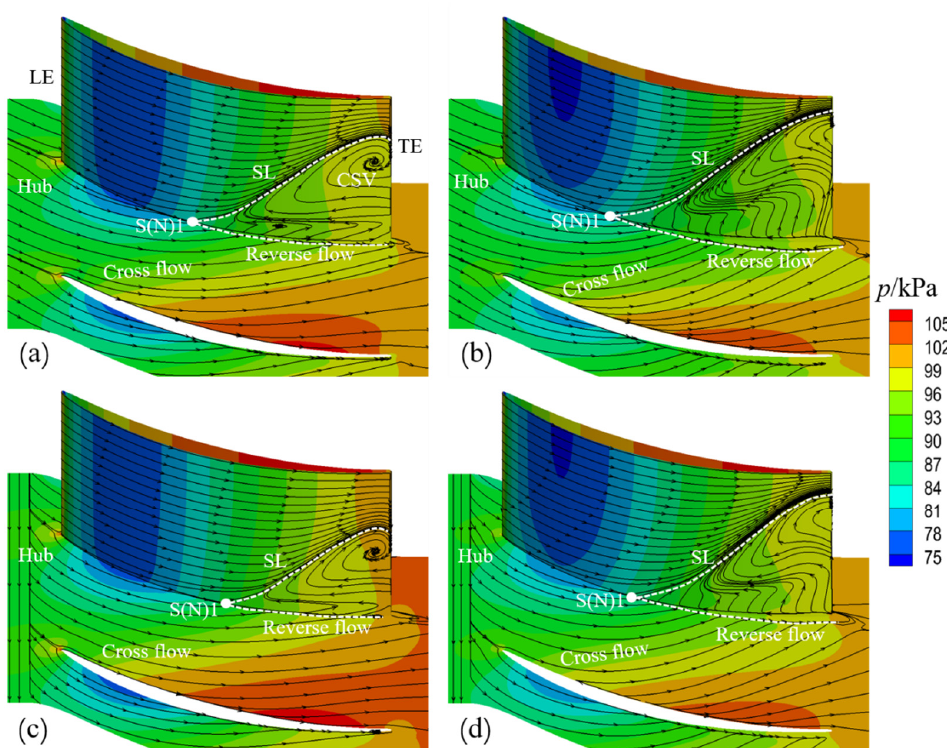
Figure 9. The limiting streamlines and static pressure contours of the original cascade endwall and suction surface: ( a ) 0 mm collateral; ( b ) 5 mm collateral; ( c ) 0 mm skewed; ( d ) 5 mm skewed.